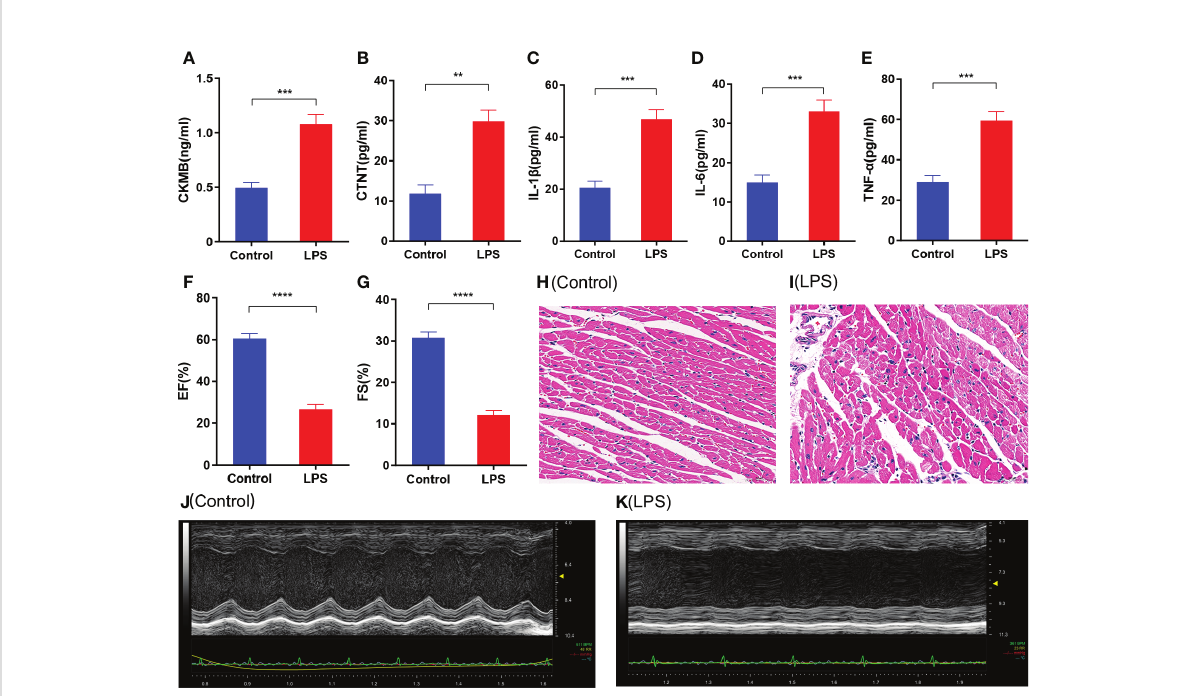
FIGURE 1 Characterization of cardiac injury and in fl ammatory response in the sepsis-induced myocardial dysfunction model mice generated by LPS treatment. (A-E) ELISA assay results show the levels of (A) CKMB, (B) CTNT, (C) IL-1 b , (D) IL-6, and (E) TNF- a in the heart tissues of the SIMD and control groups of mice. (F, G) Echocardiographic data results show the (F) left ventricle ejection fraction (LVEF) and (G) left ventricle fractional shortening values for the SIMD and control groups of mice. (H, I) Representative images show H&E stained sections of heart tissues from the SIMD and the control groups of mice. Scale bar: 50 m m. (J, K) Representative echocardiographic images of the SIMD and the control groups of mice. The columns represent the mean values, and the error bars represent the standard error of the mean (n = 5). *p < 0.05, **p < 0.01, ***p < 0.001, ****p <